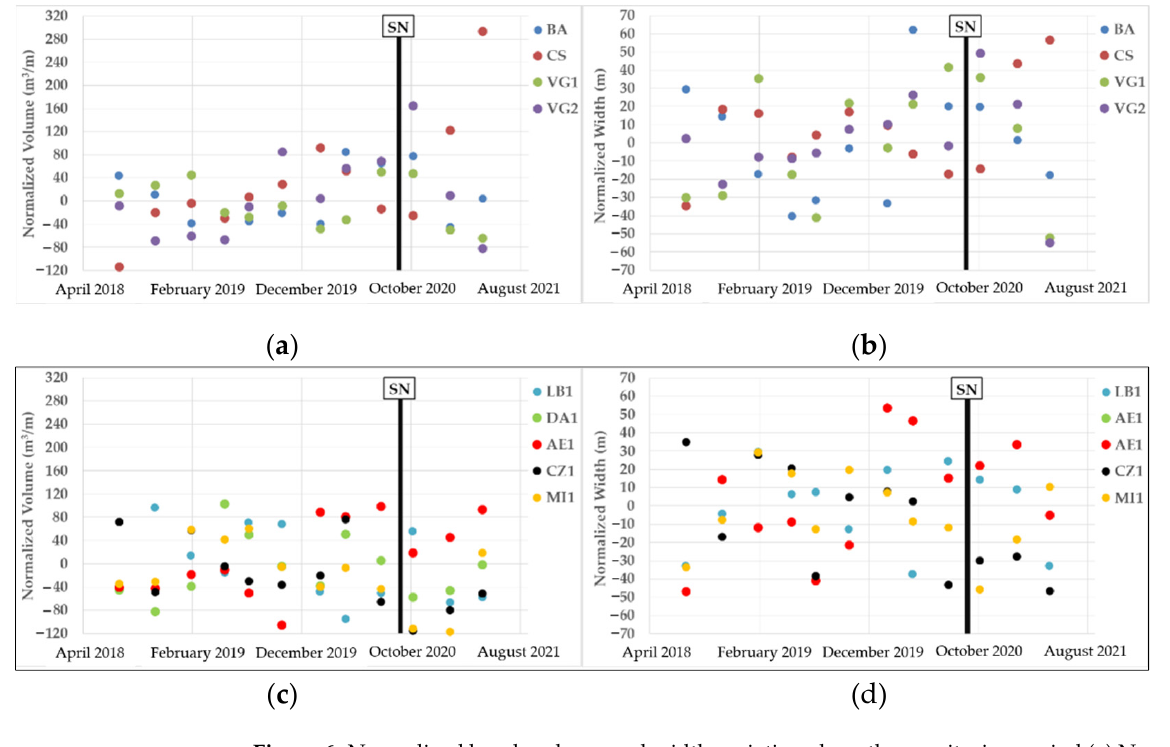
Figure 6. Normalized beach volume and width variation along the monitoring period ( a ) Normalized volume in the SD; ( b ): Normalized width in the SD; ( c ): Normalized volume downdrift of SD; ( d ) Normalized width downdrift of SD.